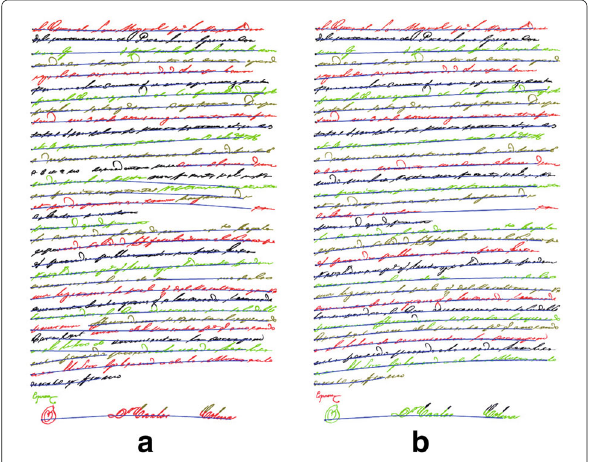
Fig. 6 a CC grouping result. b Final result by global skew estimation and CC